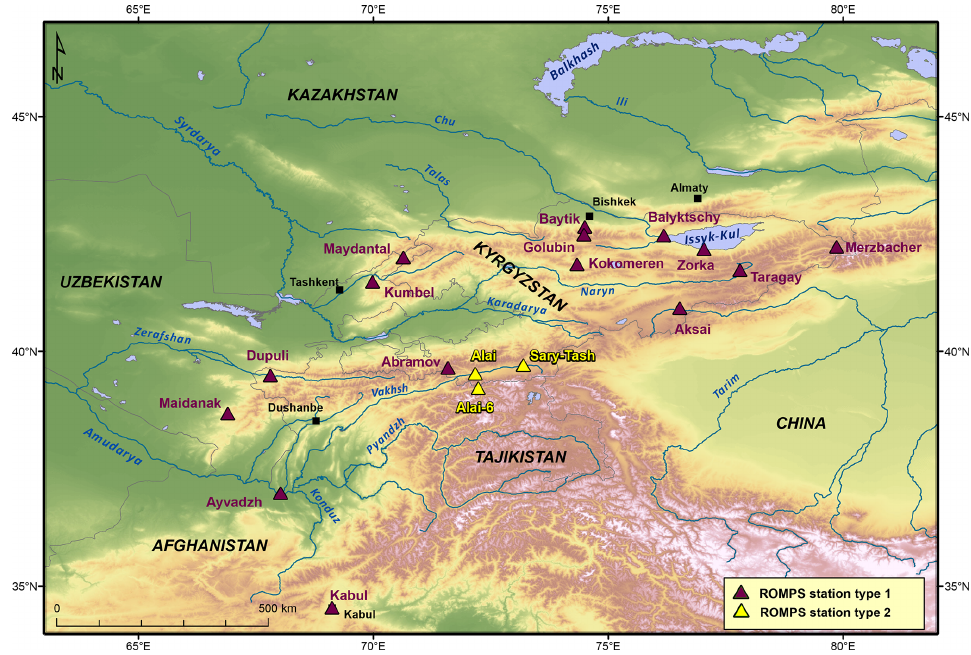
Figure 1. ROMPS network in Central Asia with the two different station types (see Sect. 3) marked in purple for station type one with individual sensors and in yellow for station type two with the compact weather transmitter (credit to NOAA for the